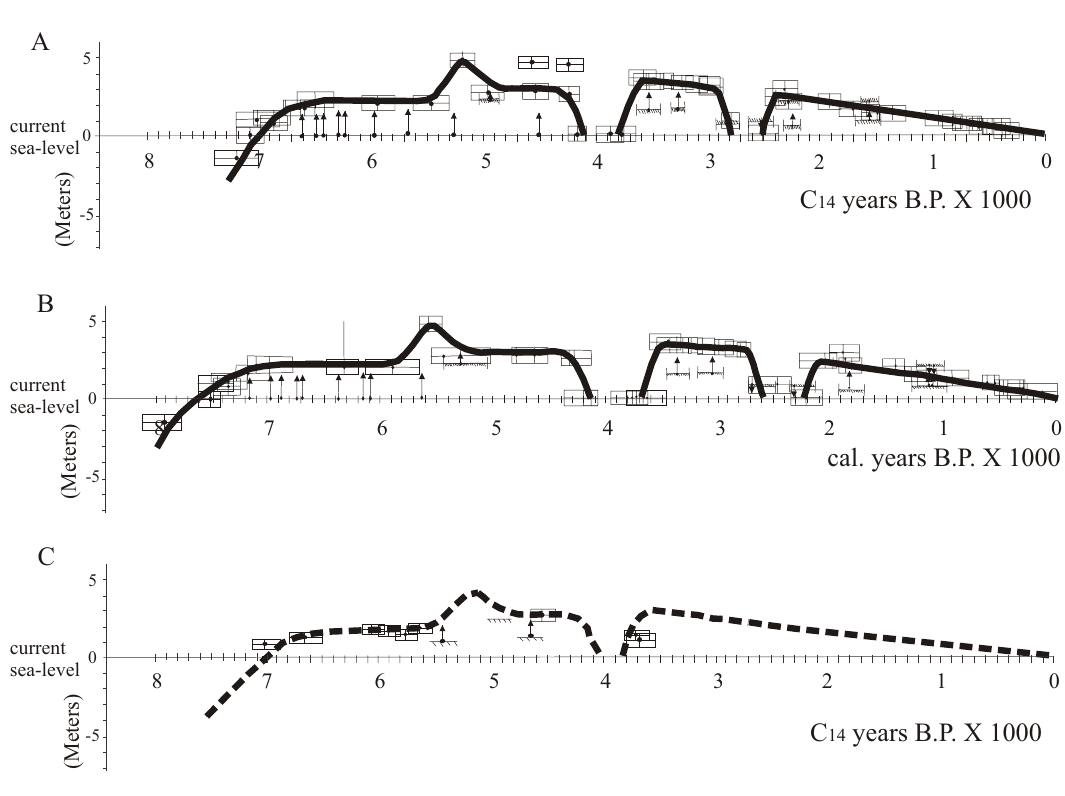
Fig. 3 – Relative sea-level curves: A – Salvador sea-level curve (radiocarbon years) (Martin et al. 1980), B – Salvador sea-level curve (calendar years) (Martin et al. 2002), C – sea-level reconstructions for the Caravelas strandplain plotted on the Salvador curve (radiocarbon years) (Martin et al.